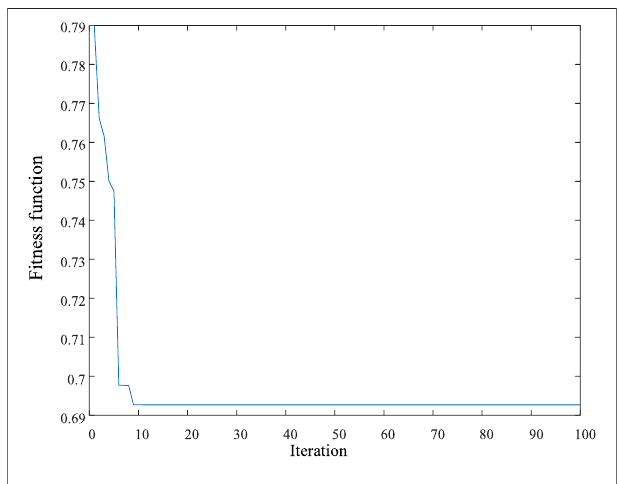
FIGURE 7 | Convergence curves.